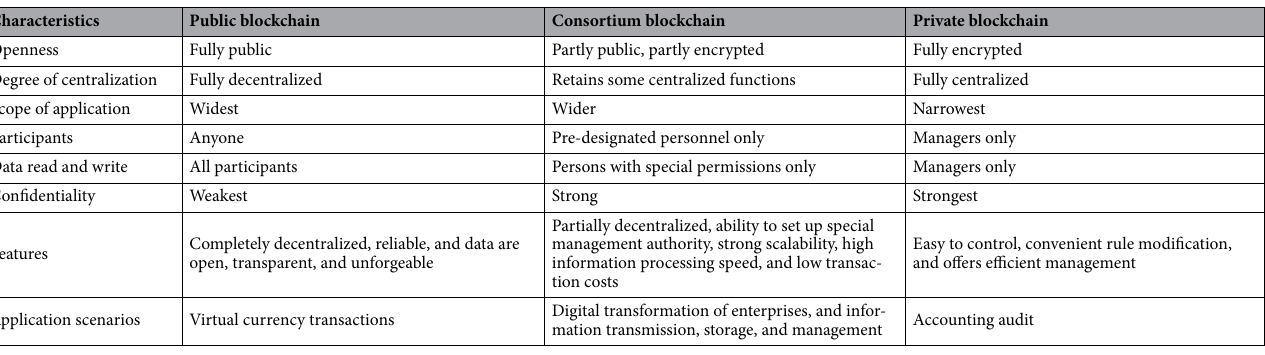
Table 1. Characteristics of the three blockchain